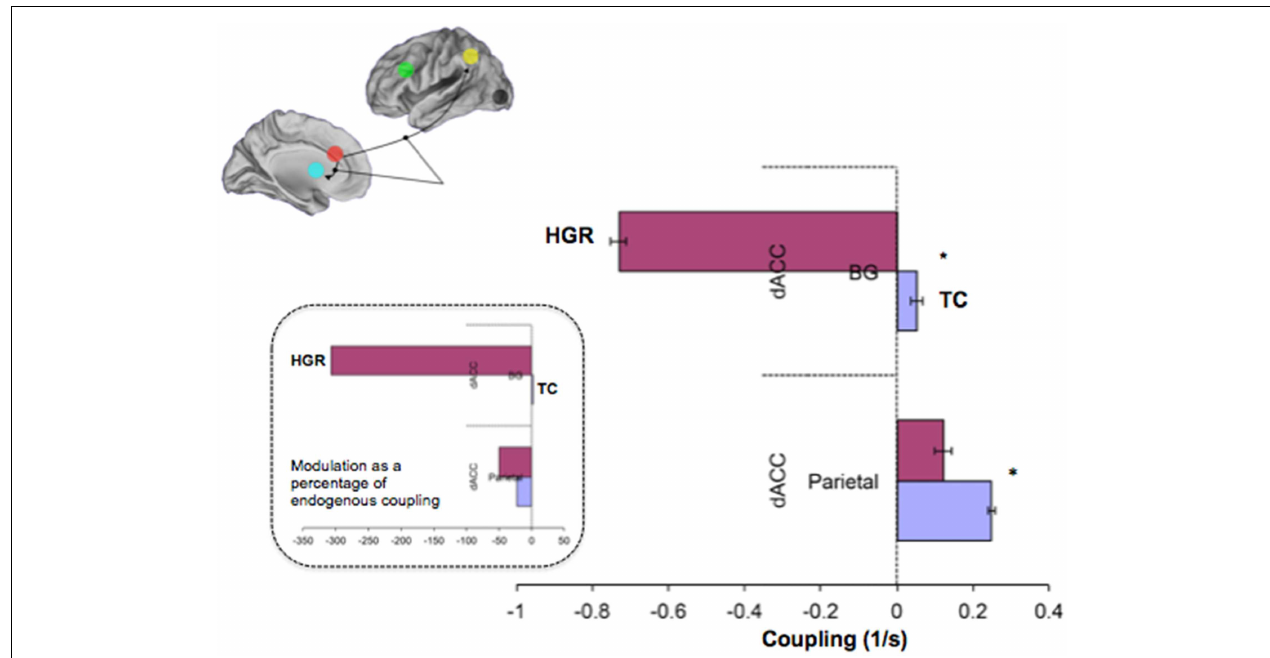
connection strength is lower when implementing attention processing. Moreover, the dACC–BG pathway in HGR is significantly inhibited during attention processing.The inset depicts contextual modulation expressed as a percentage of the endogenous coupling values ( Figure 8 ).This turning down may reflect critical sub-network disengagement in HGR during attention processing and may encode particular vulnerability for impaired attention, cognition, and control that has been documented in HGR